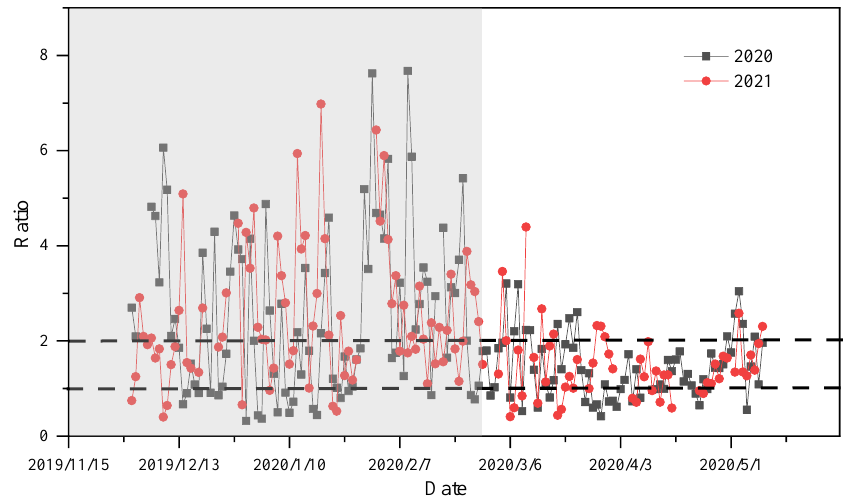
Figure 9. Daily average HCHO/NO 2 ratio at Huaibei in 2020 and 2021. Determining the sources of pollution is crucial for monitoring air pollution. O 3 is mainly produced through atmospheric photochemical reactions, so O 3 concentrations can be used as an indicator of atmospheric photochemical reaction intensity. Research has shown that HCHO is mainly generated from atmospheric photochemical reactions in the Huairou area of Beijing [10]. To further determine whether the pollution sources of HCHO in Huaibei were due to primary or secondary formations from other VOCs, the correlation of HCHO with primary pollutants (NO 2 and SO 2 ) or secondary pollutants (O 3 ) was analyzed (Figure 10). The daily averaged values of different gases for all the observation periods in 2020 and 2021 were selected for the study period. It can be seen from Figure 10 that the correlation coefficients R 2 of HCHO and SO 2 in 2020 and 2021 are 0.86 and 0.89, respectively. In contrast, the correlation coefficient between NO 2 and HCHO is less than 0.1, and between O 3 and HCHO is less than 0.3. Therefore, HCHO in Huaibei mainly comes from primary industrial emissions related to SO 2 , and the proportion of HCHO generated by atmospheric photochemical reactions is low. Temperature changes in spring can affect the natural source emissions of HCHO. Figure 11 shows the temperature changes during the observation periods of the two years. It can be seen that the temperature in the spring did not significantly change in two years. The influence of natural sources on the differences in HCHO concentrations was therefore excluded. In addition, during the cold period in 2021, more heating was needed, probably also contributing to changes in NO 2 and SO 2 .